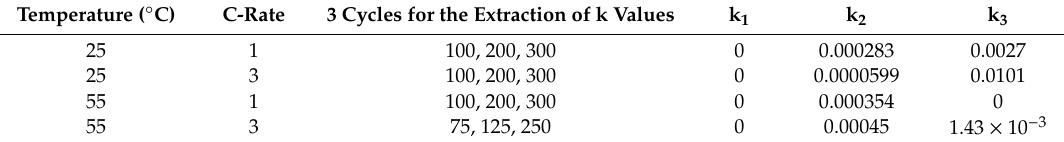
Table 3. k values of the semi-empirical capacity fading (SECF) model obtained at four test conditions. Temperature ( ◦ C)